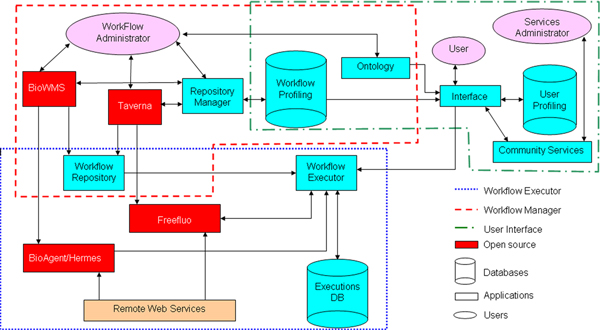
The conceptual architecture of biowep. The architecture of biowep includes three components. The Workflow Manager (WM) for the creation of predefined workflows by using Taverna or BioWMS, and their annotation that is done by using a classification of bioinformatics tasks (ontology). The User Interface (UI) supports end users authentication and profiling and selection and enactment of workflows. This can be carried out by searching workflows annotations. The Workflow Executor (WE) enacts workflows by using FreFluo or by submitting them to BioAgent/Hermes. In this figure, red blocks refer to open source software already available, light blue block refer to original software/database.